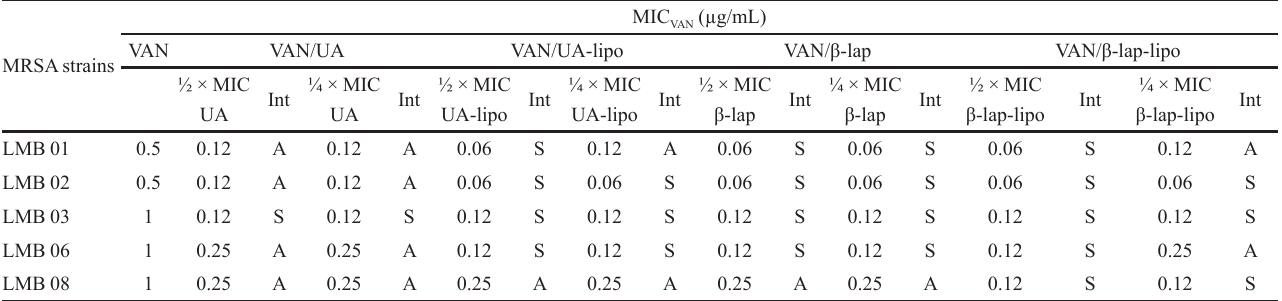
VAN: vancomycin; UA: Usnic acid; UA-lipo: UA-loaded liposomes; β-lap: β-lapachone; β-lap-lipo: β-lap-loaded liposomes. A: additive; S: synergistic.